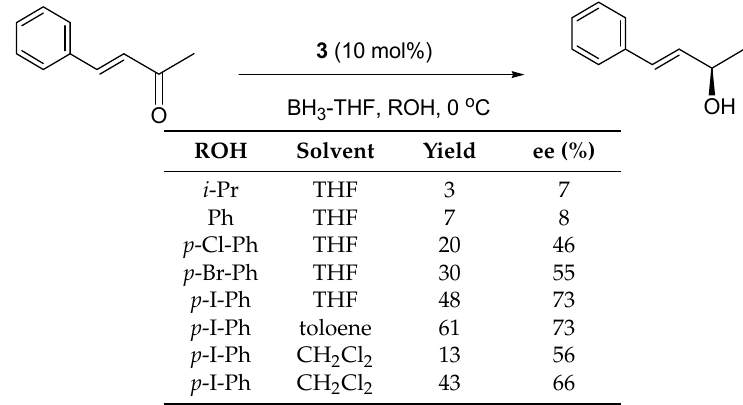
Table 1. Asymmetric reduction of α , β -enones using the chiral lactam alcohol 3 a .